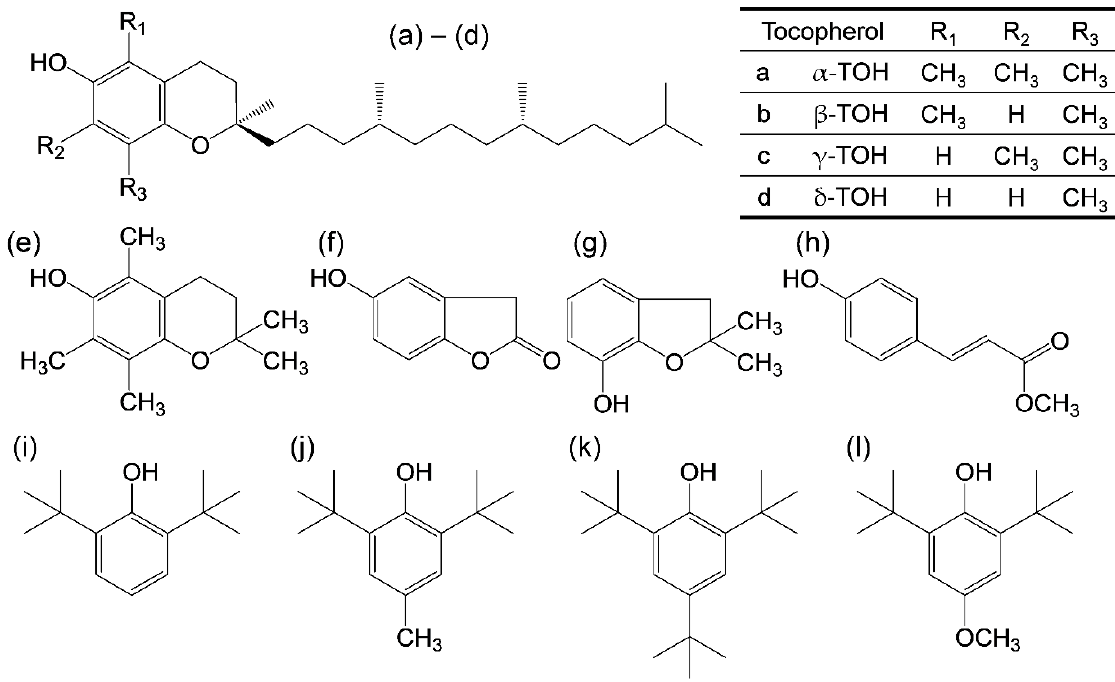
Figure 1. Structures of TOH and the related compounds considered in this study. ( a – d ) α -, β -, γ -, and δ -TOH, ( e ) 2,2,5,7,8-pentamethyl-6-chromanol, ( f ) homogentisic acid γ -lactone, ( g ) 2,3-dihydro-2,2-dimethyl-7-hydroxybenzofuran, ( h ) trans- para -coumaric acid, ( i ) 2,6-di-tert-butyl-phenol (2,6-DTBP), ( j ) 2,6-di-tert-butyl-4-methylphenol (2,6-DTBM), ( k ) 2,4,6-tri-tert-butyl-phenol (TTBP), and ( l ) 2,6-di- tert-butyl-4-methoxyphenol